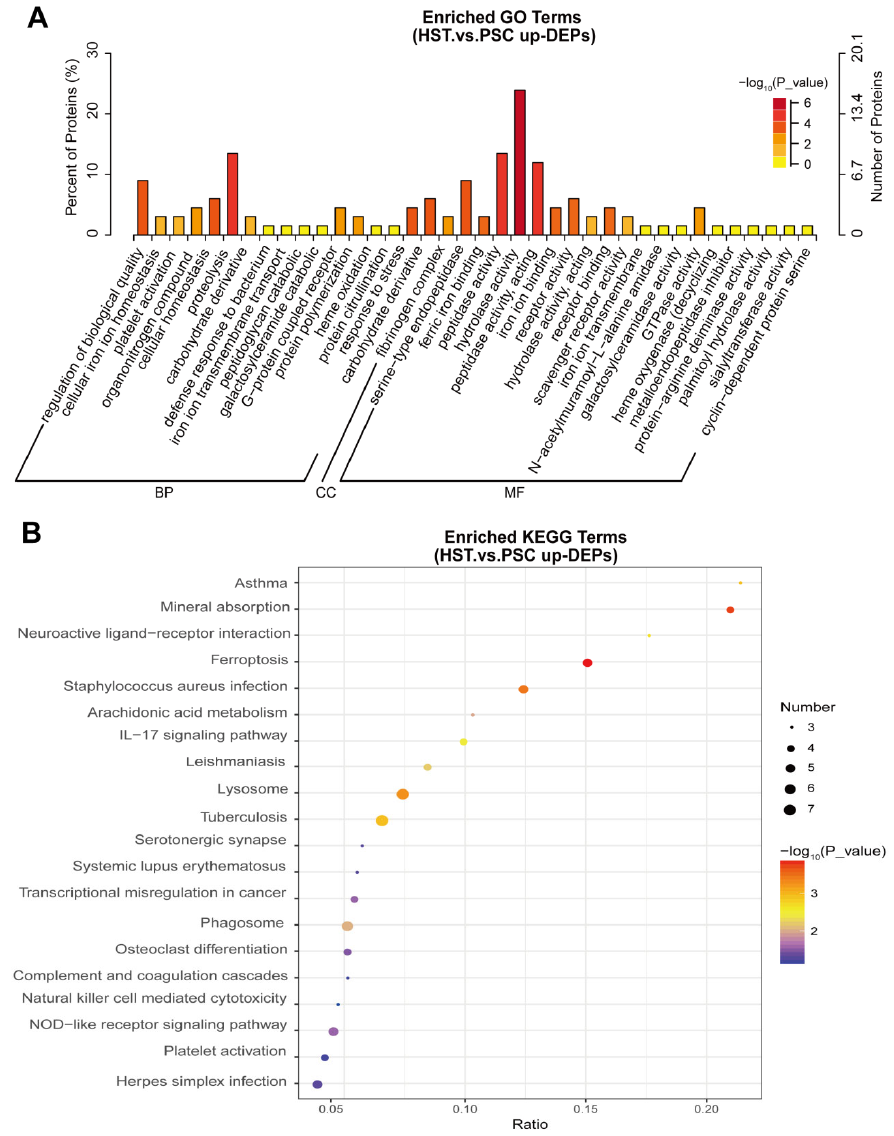
Figure 2. GO and KEGG based on upregulated differentially expressed proteins (DEPs) annotated based on proteomics analysis using spleen samples of mice subjected either by normaxia or hypoxia treatments. ( A ), GO analysis. ( B ), KEGG analysis. BP, CC and MF represent biological pathway, cellular components and molecular function, respectively.